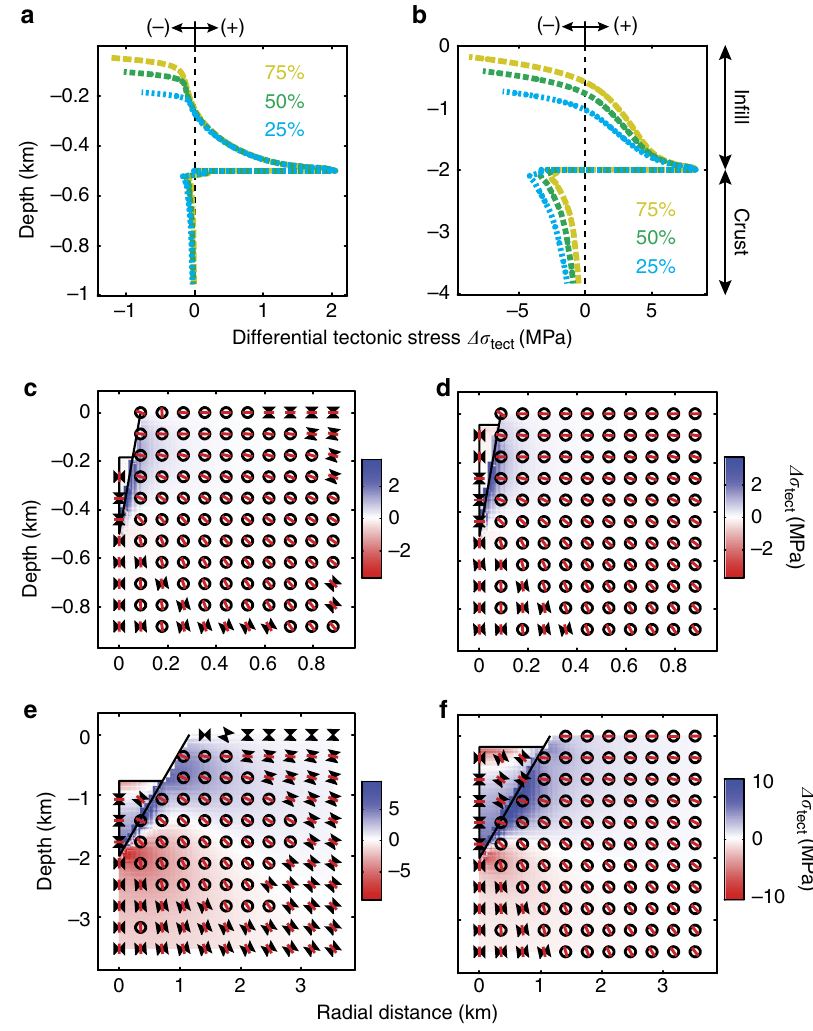
Fig. 3 State of stress within the diatreme ’ s in fi ll and the surrounding crust. a , b Differential tectonic stress along the symmetrical axis of the model (left boundaries) for different diatreme ’ s depth D d = 500 m ( a ), D d = 2000 m ( b ), dipping angles α = 80° ( a ), α = 60° ( b ), and in fi ll volume (colors blue, green, and yellow for 25, 50, 75% of in fi ll, respectively). c – f Differential tectonic stress and stress orientation within the in fi ll and the crust for different diatreme geometries and in fi ll volumes, c D d = 500 m, α = 80°, 25% in fi ll; d D d = 500 m, α = 80°, 75% in fi ll; e D d = 2000 m, α = 60°, 25% in fi ll; f D d = 2000 m, α = 60°, 75% in fi ll. Legend as in Fig.